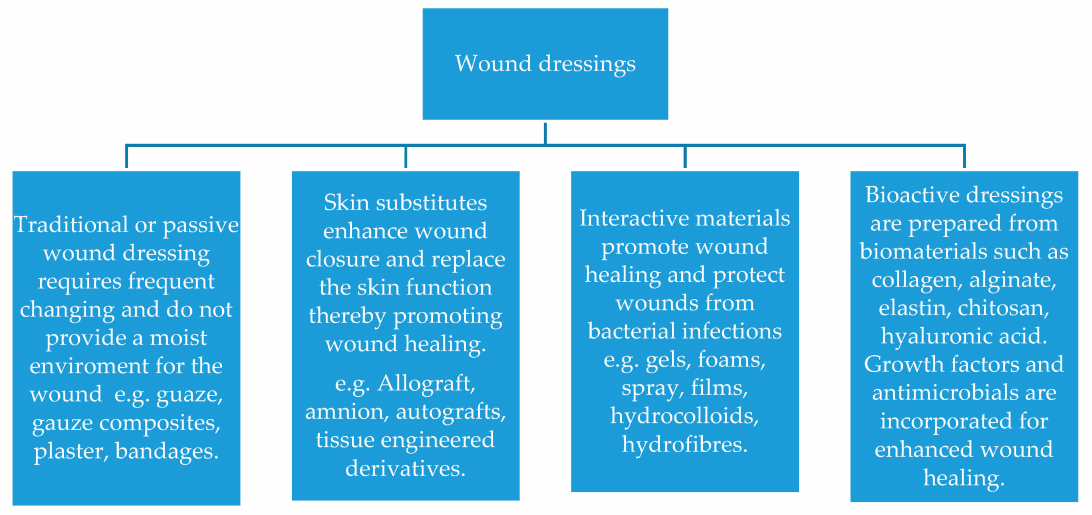
Figure 2. Classification of wound dressings [2]. Reprinted from an open-access